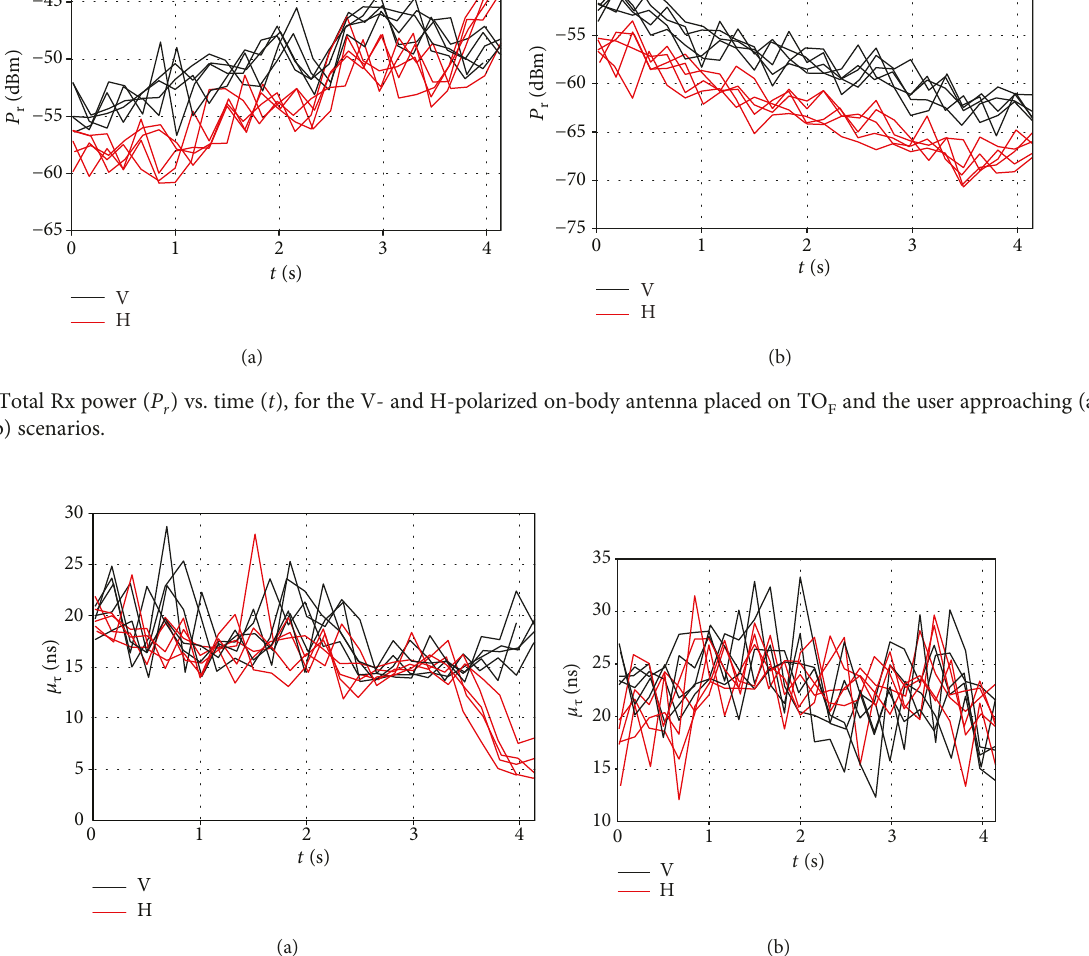
Figure 11: Average delay ( μ departing (b) scenarios.